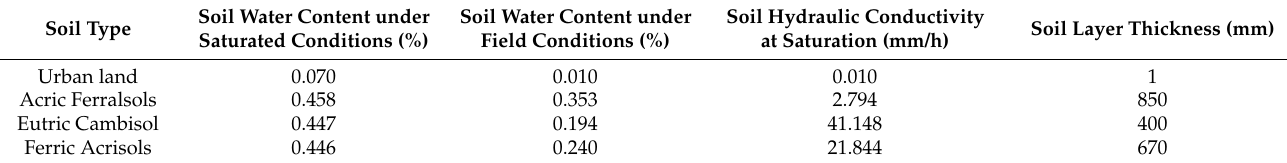
Table 2. Soil-based